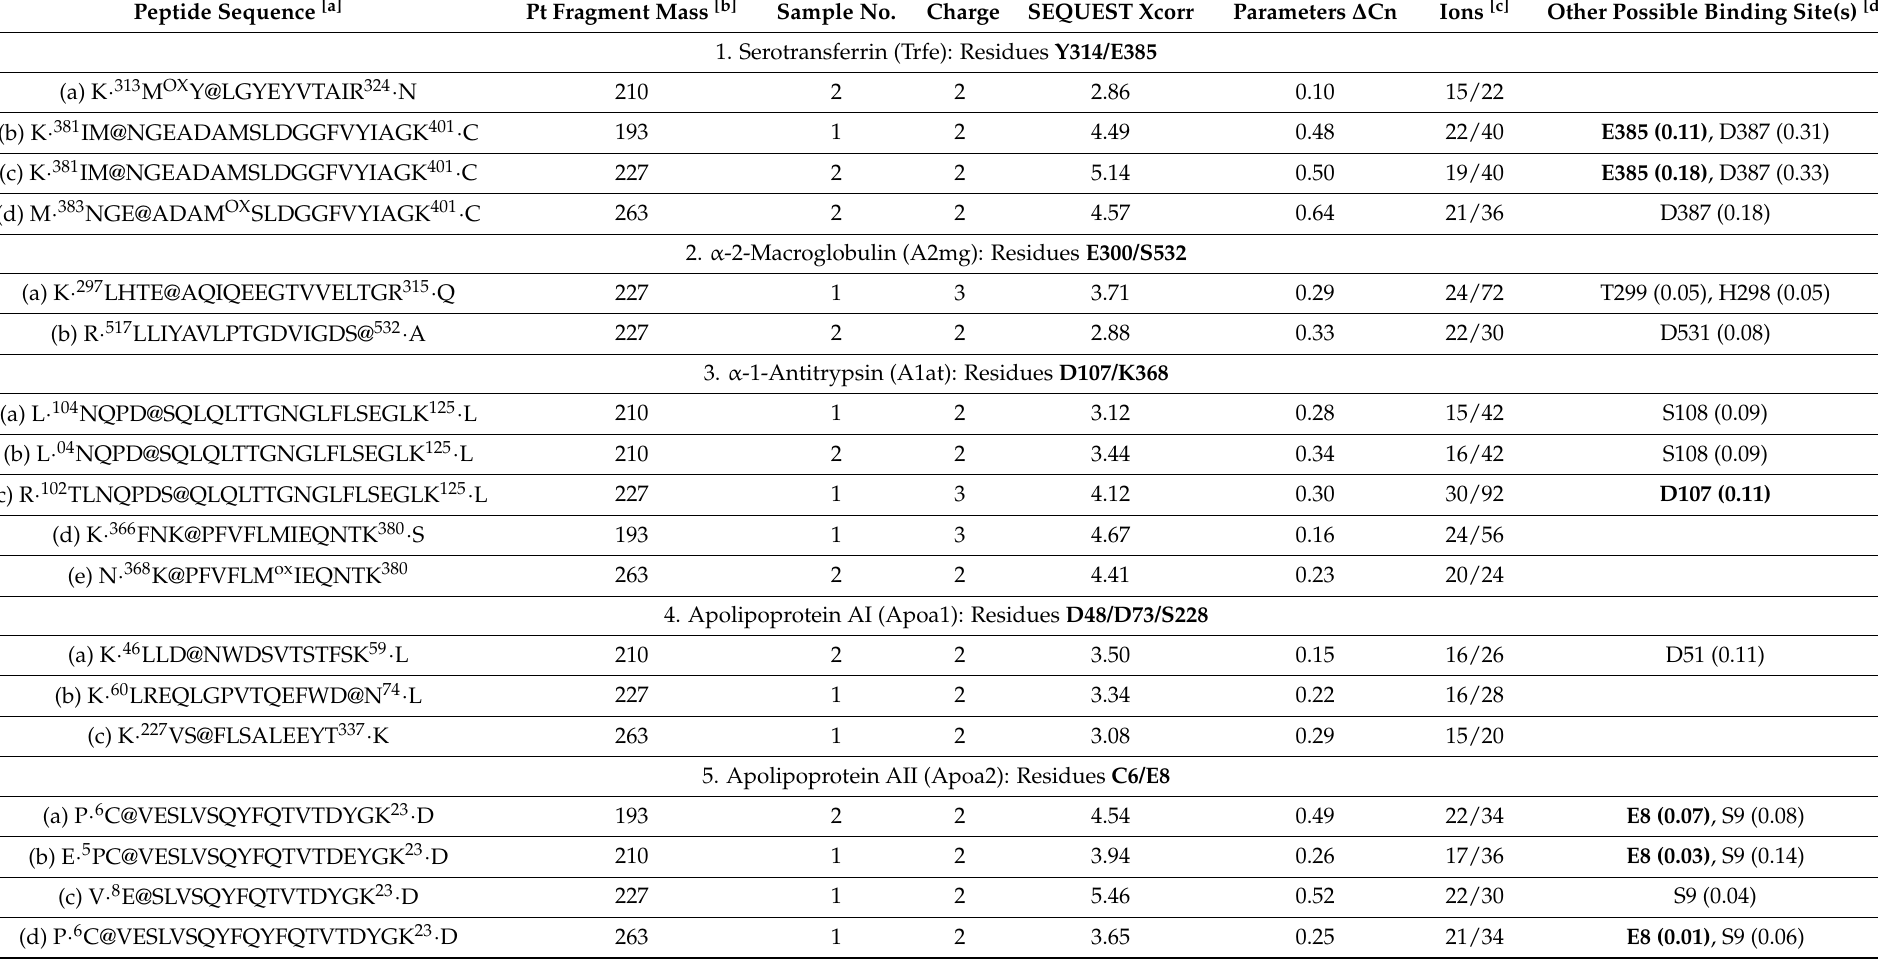
Table 3. Platinated peptide sequences of other abundant proteins in blood serum. Reprinted with permission from [65]. Peptide Sequence [a] Pt Fragment Mass